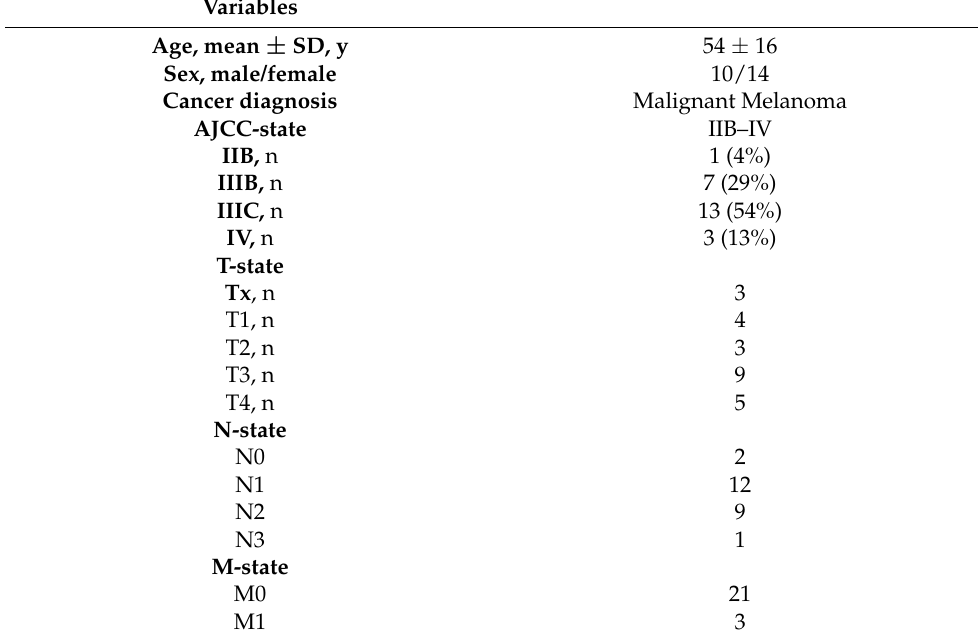
Table 1. Patients’